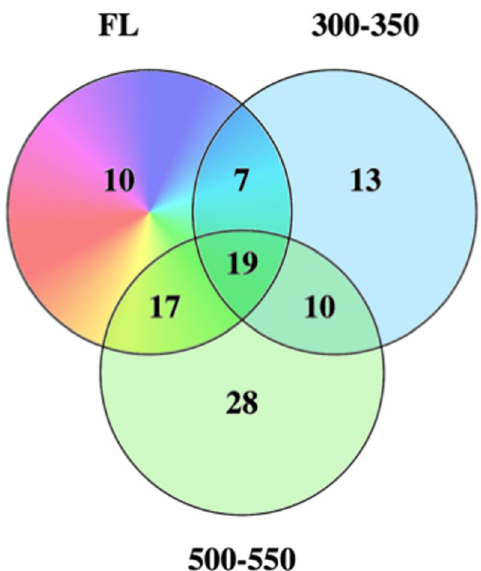
Figure 5. Upstream regulators modulated in FL and the two primary shared wavebands within the FL spectrum. While both regions have significant gene identity sharing with the FL exposed brain samples, the 300–350 nm region oppositely modulated genes compared to FL and the 500–550 nm region modulated genes in the same direction as FL (Table